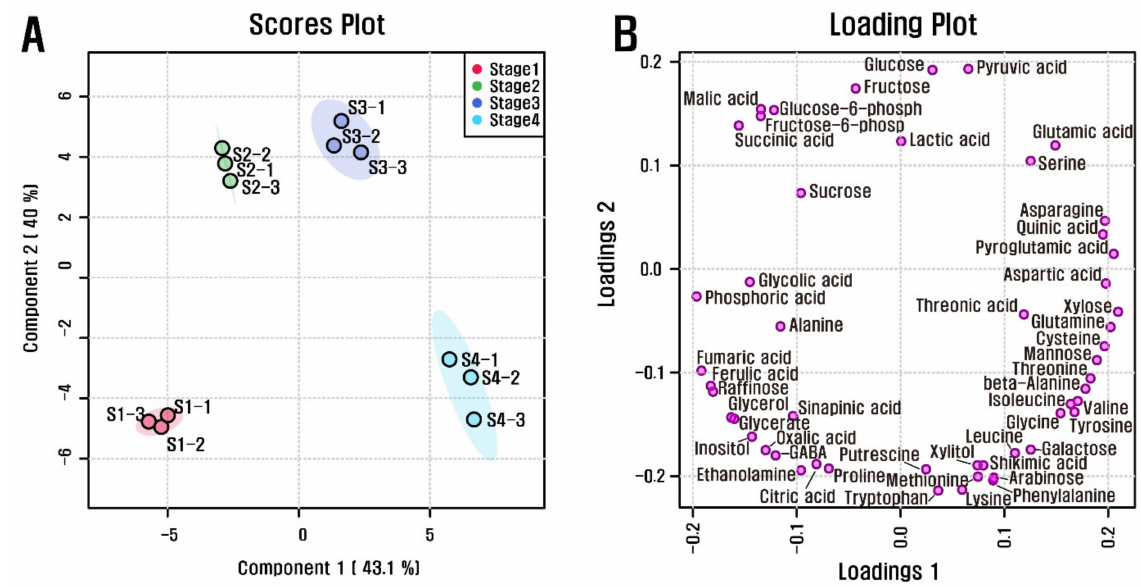
Figure 3. ( A ) Scores and ( B ) loading plots of PLS-DA model obtained from 51 metabolites from L . radiata at the different flower developmental stages using